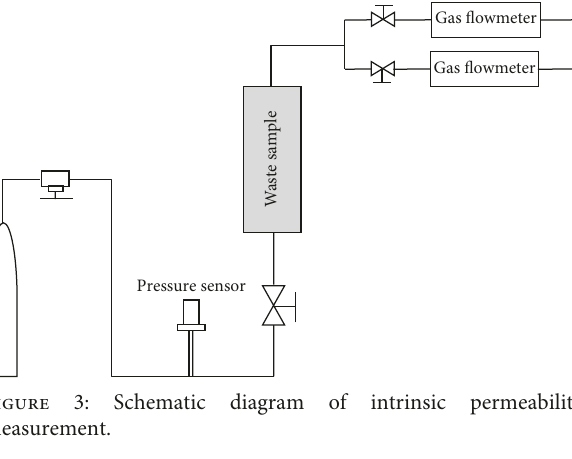
Figure 3: Schematic diagram of intrinsic permeability